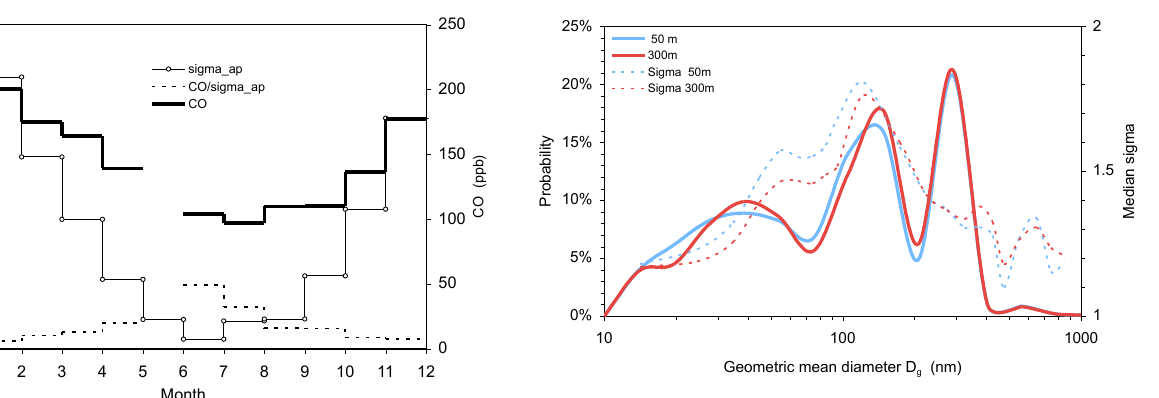
Fig. 4. Monthly medians of the particulate absorption coefficient at 570nm ( σ ap , Mm − 1 ), CO concentrations (ppb), and the ratio CO/ σ ap at ZOTTO; averages of 50m and 300m.